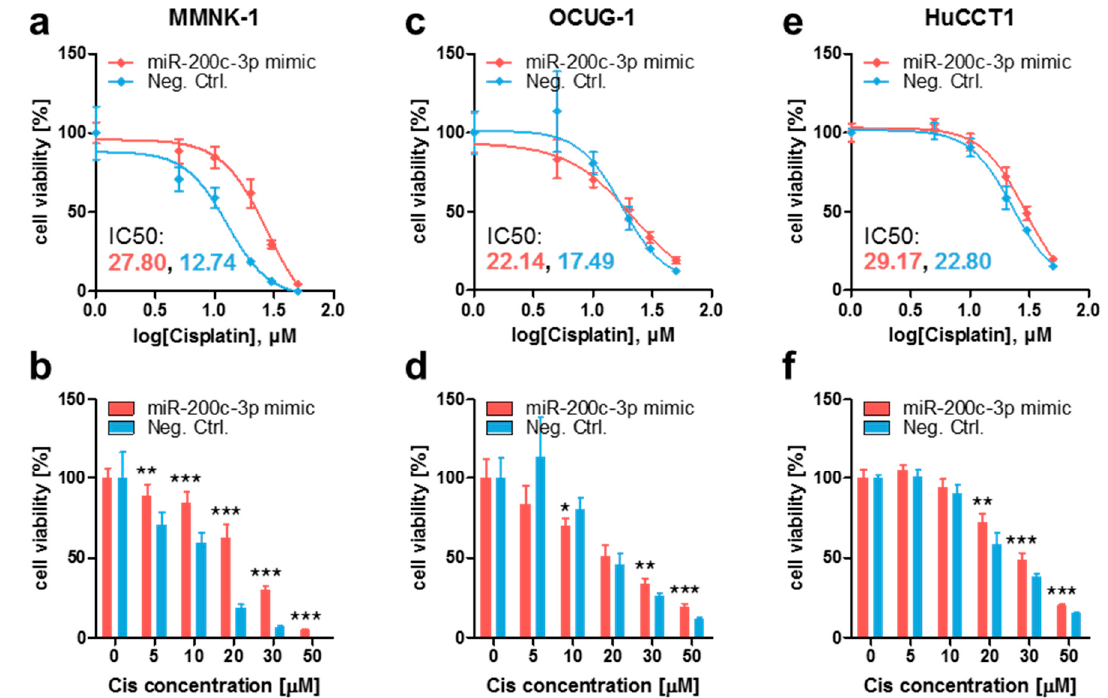
Figure 3. Transient miR-200c-3p overexpression renders immortalized cholangiocytes and BTC cells more resistant to cisplatin. ( a , b ) MMNK-1, ( c , d ) OCUG-1, and ( e , f ) HuCCT1 cells were transfected with 10 nM mirVana miR-200c-3p mimic (miR-200c-3p mimic) or mirVana mimic Negative Control (Neg. Ctrl.) for 24 h and subsequently treated with various concentrations of cisplatin (Cis). After 48 h, cell viability was assessed by adding WST-1 reagent and measuring absorbances at 450 nm and 620 nm (reference wavelength). Cells treated with cisplatin were normalized to untreated (0 μ M) cells (set to 100%). ( a , c , e ) Ordinary least-squares regression with outlier removal following the ROUT method was used to determine the inhibitory concentration 50% (IC50) values. ( b , d , f ) Unpaired two-tailed t-test was used to evaluate statistical significance. * p < 0.05, ** p < 0.01, *** p < 0.001.